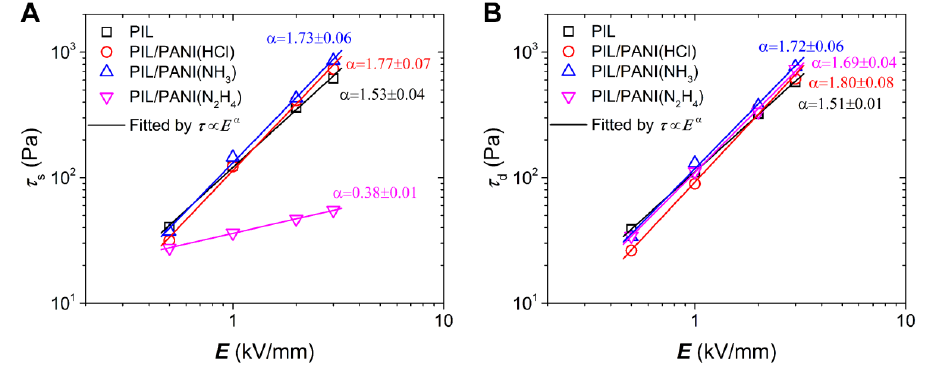
Figure 6. ( A ) Static yield stress and ( B ) dynamic yield stress as a function of electric field strength for the ER fluids ( T = 25